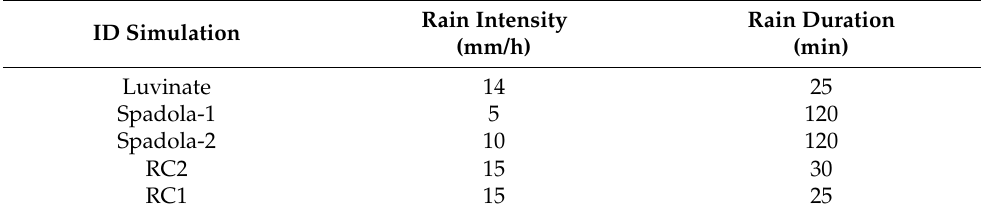
Table 2. Simulations and rainfall scenarios.